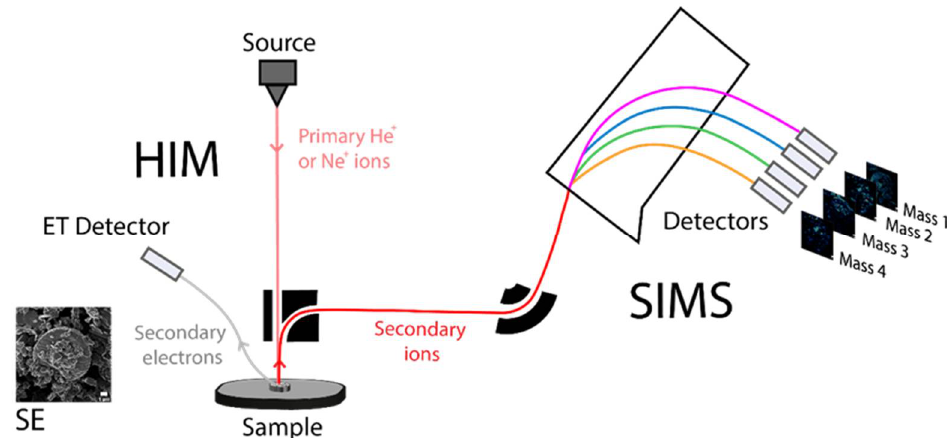
Figure 3. Schematic view of the HIM-SIMS instrument. The central part consists of the helium ion microscope (HIM) used primarily for topographic SE imaging, while the left part is showing the coupled secondary ion mass spectrometer (SIMS) add-on system dedicated for elemental analysis.